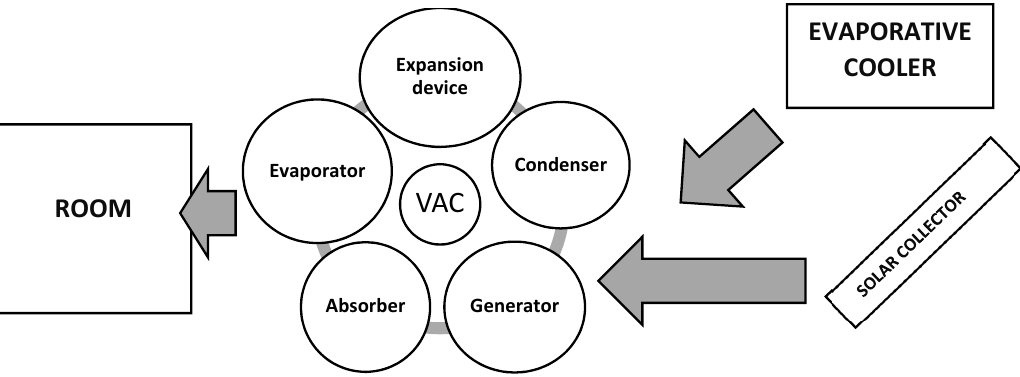
Fig.3 Solar vapor absorption system with evaporative cooling of condenser